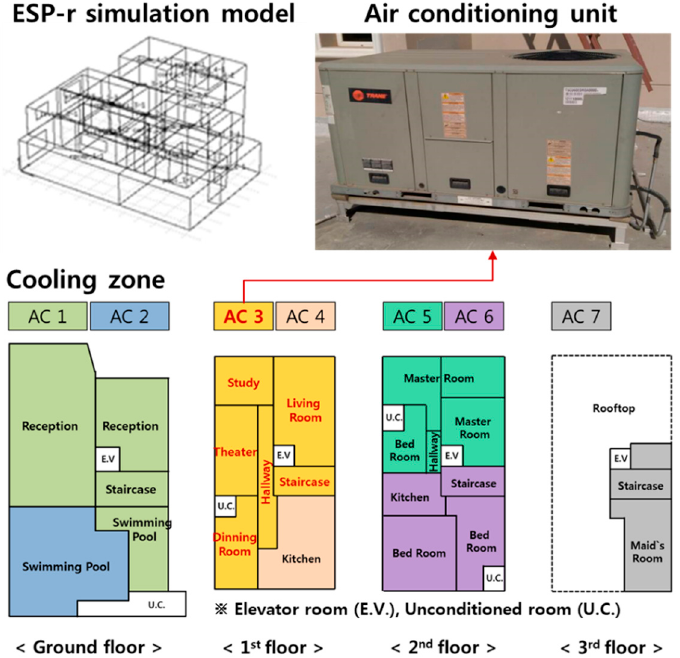
Figure 4. ESP-r simulation model and classification of cooling zones.